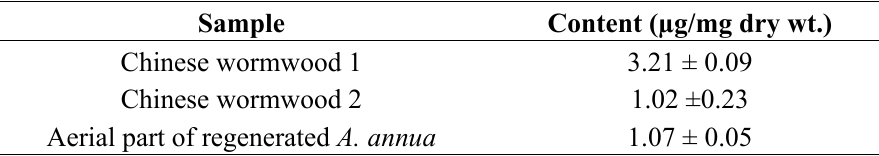
Table 1. Content of artemisinin and its structurally related compounds in Artemisia annua L. samples determined by icELISA using anti-AM mAb